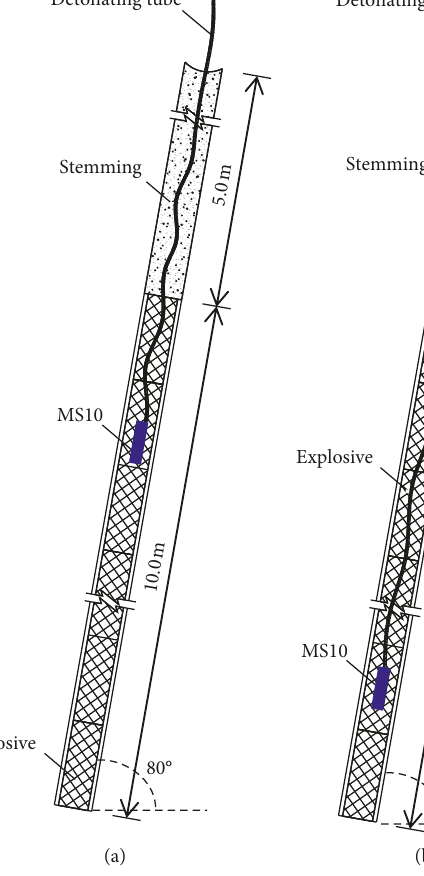
Figure 25: Charging structures of the single blastholes (a) S1 (top initiated) and (b) S2 (bottom initiated) in the production blasting experiment.